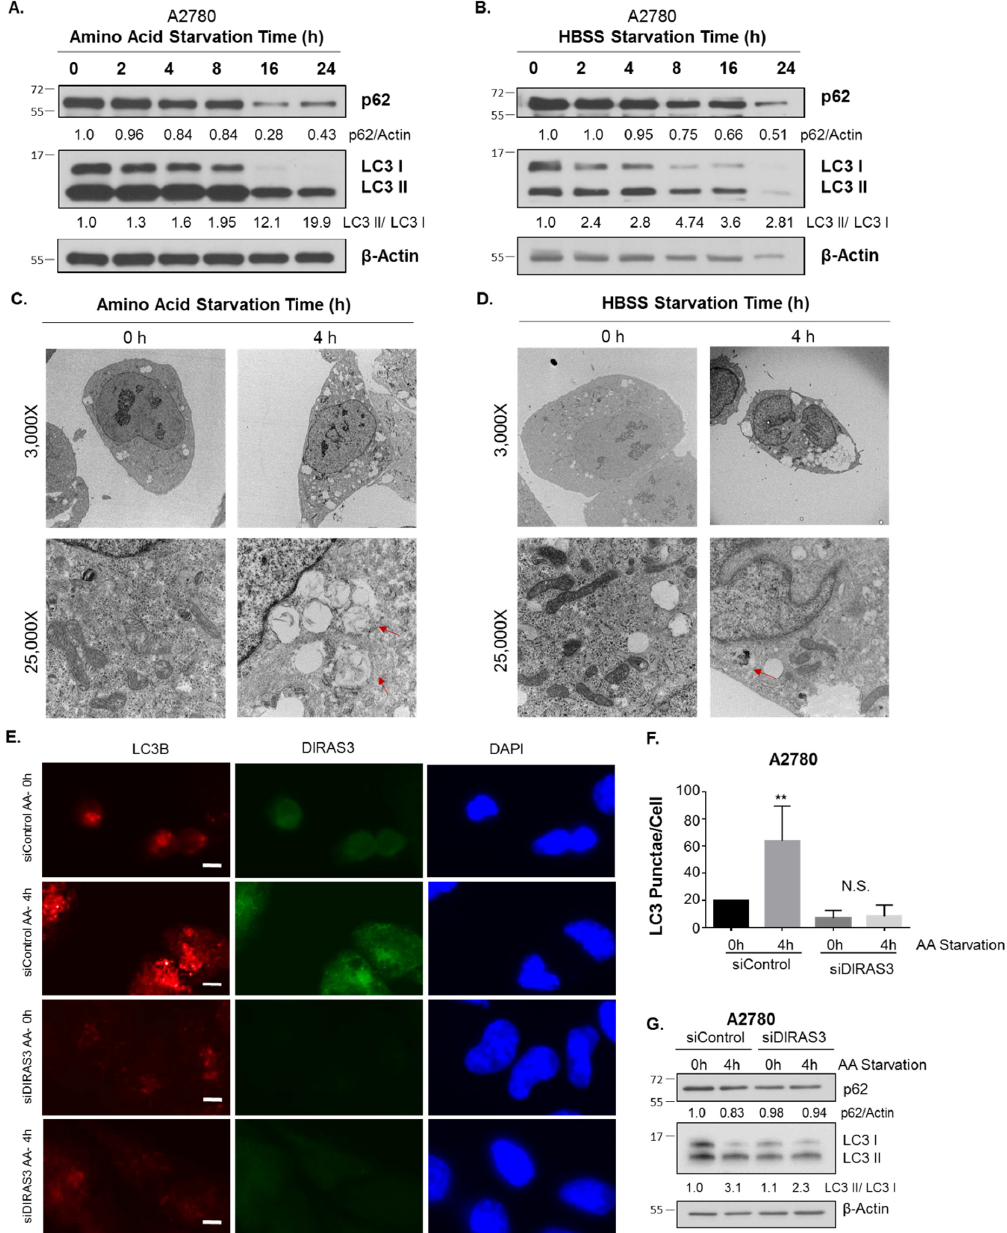
Figure 1. Starvation induces DIRAS3 mediated autophagy in A2780 ovarian cancer cells. A2780 ovarian cancer cells were treated from 0–24 h with amino acid free RPMI media ( A ) or HBSS containing 3% glucose ( B ) and western blot analysis performed. Densitometry was performed on the blots using ImageJ and calculations were normalized to the 0 h timepoint. Transmission electron micrographs were obtained following amino acid starvation ( C ) or HBSS Starvation ( D ) for 0 h or 4 h. Images were captured at 3000 × and 25,000 × magnification. Red arrows indicate typical double-membrane autophagosomes. ( E ) Immunofluorescence staining was performed following siRNA depletion of DIRAS3, with or without amino acid starvation for 4 h. LC3B puncta were visualized and quantified for each condition, as well as DIRAS3 expression and DAPI nuclear staining. Scale Bar represents 10 µ m. Quantification of LC3B puncta was obtained for at least 100 cells over three independent experiments and is depicted in ( F ). ( G ) Western blot analysis was performed following siRNA depletion of DIRAS3, with or without amino acid deprivation for 4 h. Image J was used to quantify the band intensity and were normalized to the siRNA Control 0 h timepoint. Statistical significance is denoted as ** p < 0.01. Raw data films for western blot analysis shown in Figure